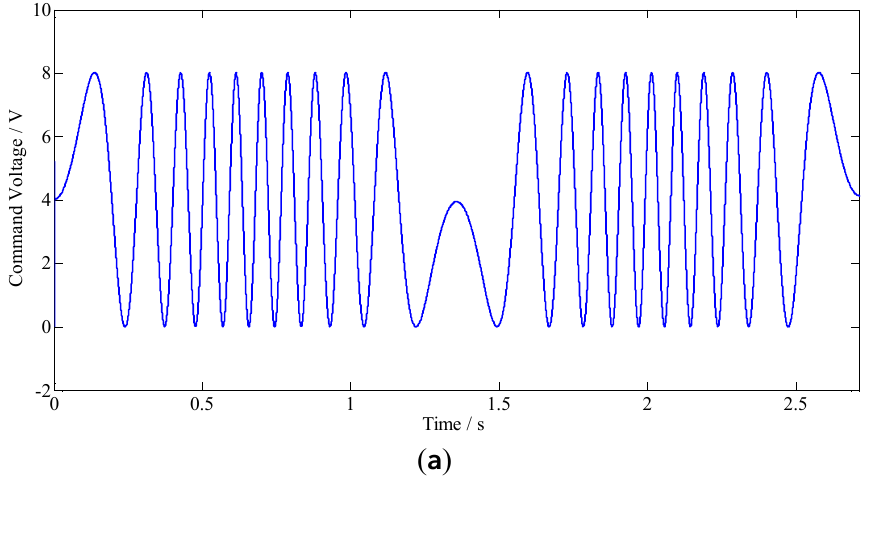
Figure 9. Modeling results (In Figure 9b, the red line and blue line denote the output of the model and the FTS, respectively.): ( a ) The control voltage; ( b ) Responses of the FTS and the proposed model; ( c ) The modeling